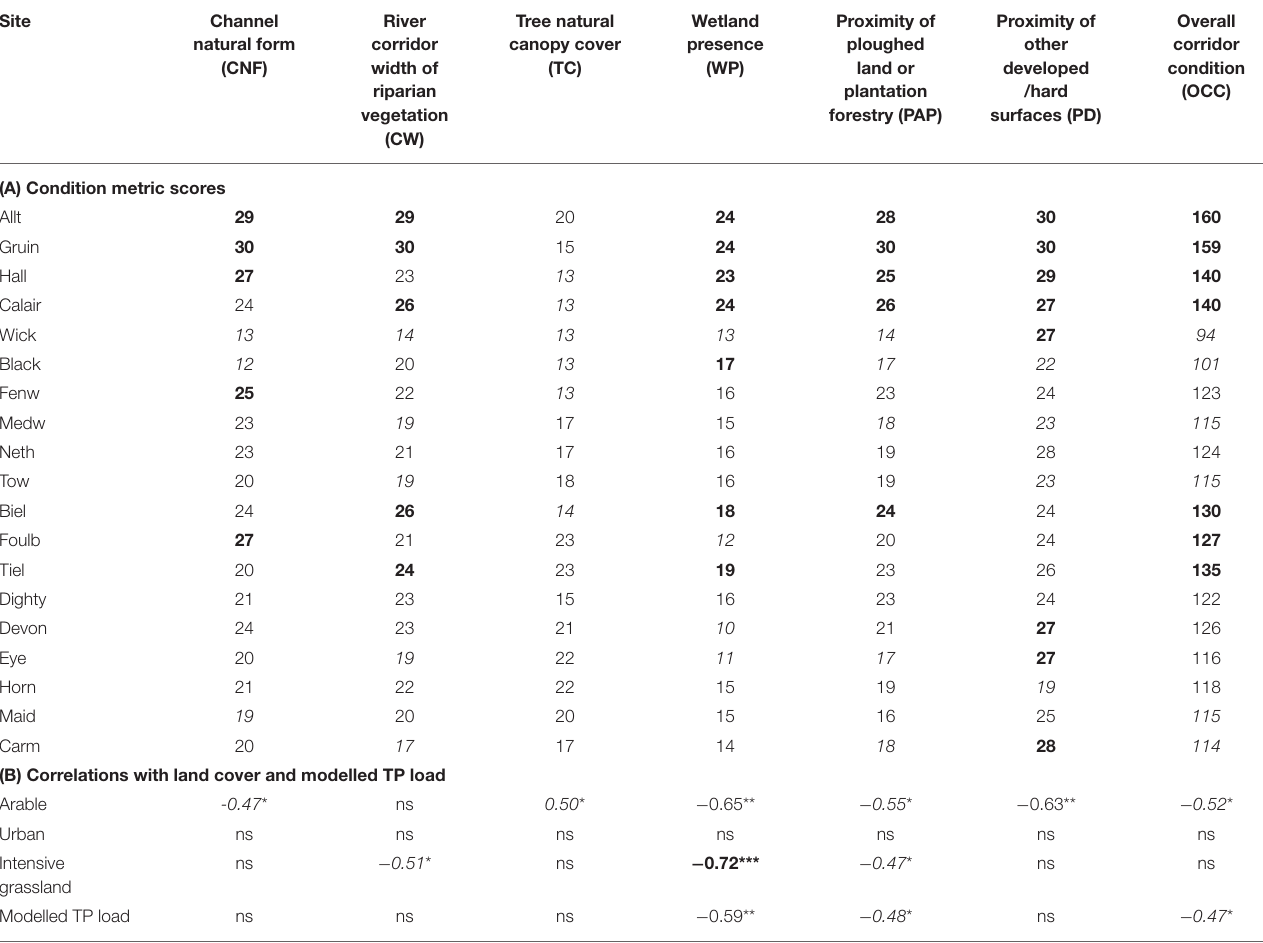
TABLE 5 | (A) Visual assessment of structural attributes along stream corridors and (B) Correlations with selected variables.